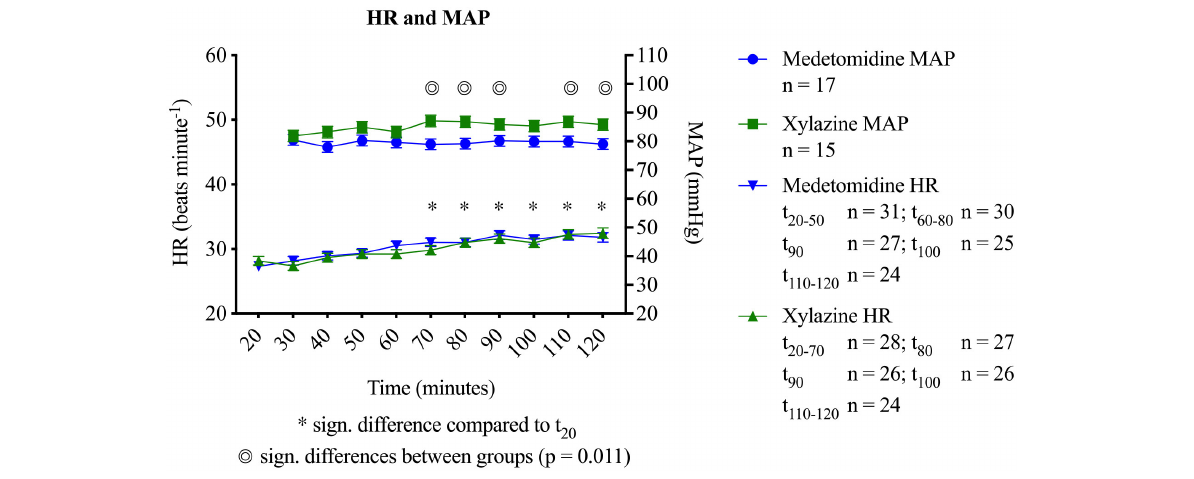
FIGURE 1 | Heart rates (HR) and mean arterial blood pressures (MAP) in horses during medetomidine isoflurane (group MED) or xylazine isoflurane (group XYL) balanced anesthesia (mean ± SEM). Significant differences between groups is marked with a double circle ( ). Time points with significant difference to t 20 are marked with asterisk (*). Represented on the x-axis are minutes after anesthesia